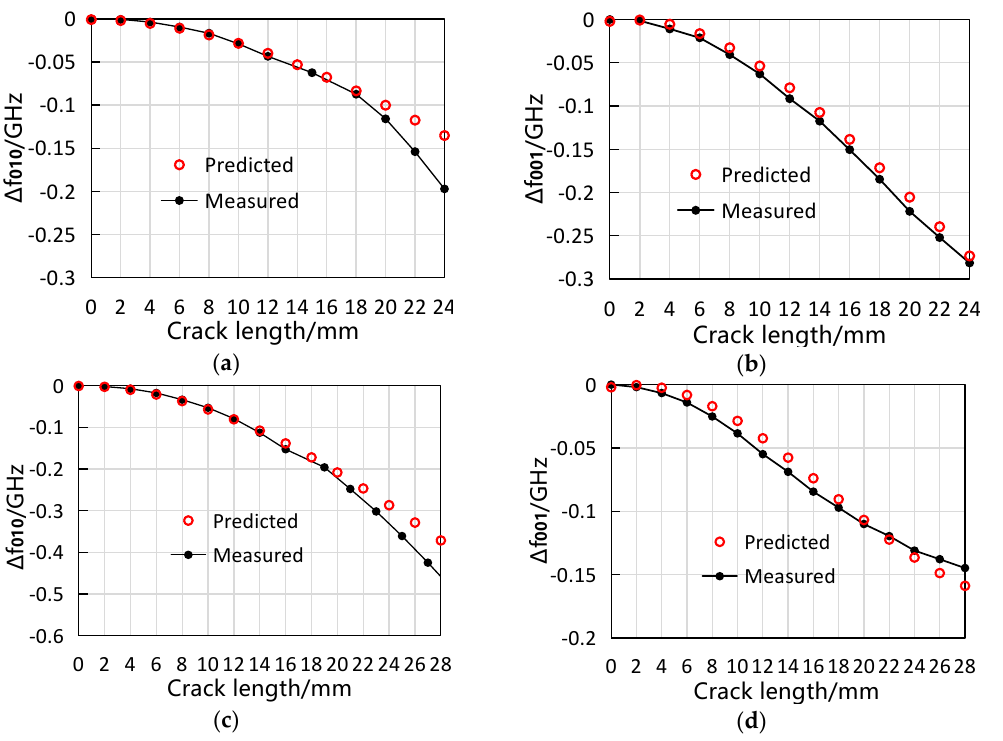
Figure 14. Evaluation of the proposed algorithm. ( a , b ) comparison between the measured and the predicted resonant frequency response for case 𝑃 = (7,3) and θ = 40° ; ( c , d ) comparison between the measured and the predicted resonant frequency response for case 𝑃 = (4,2) and θ = 55° .